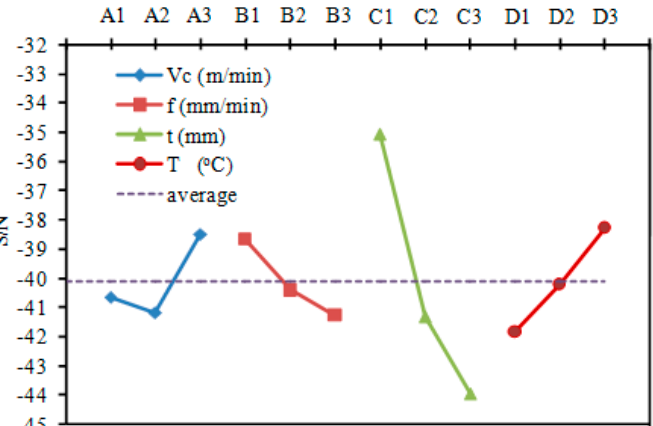
Figure 7. S/N ratios of control parameters at elevated temperatures.